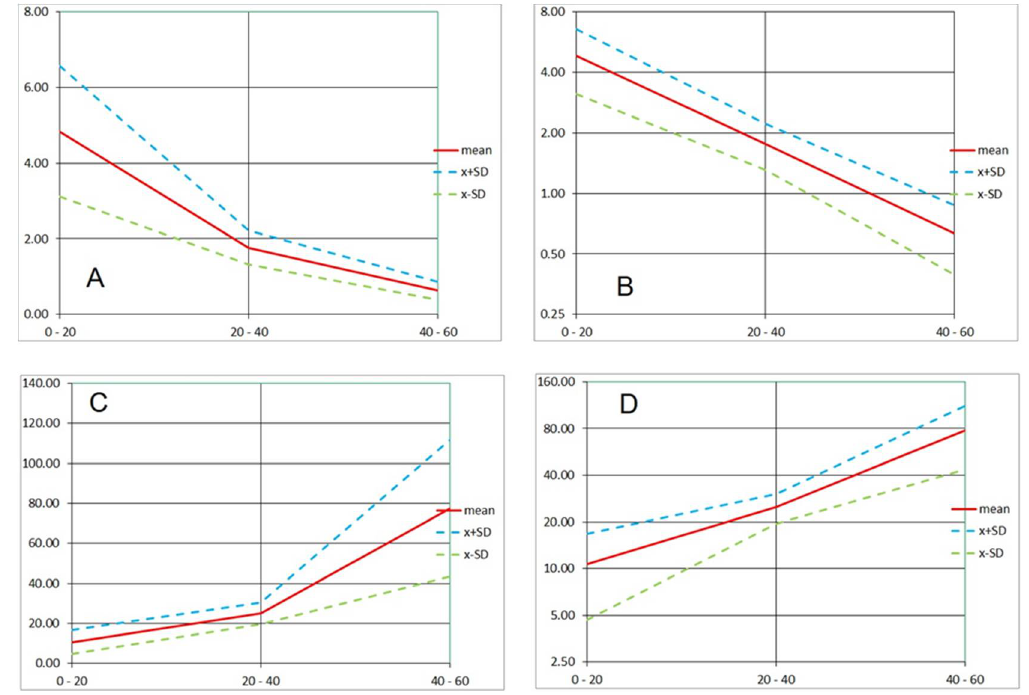
Figure 12. Timing of the Product “A” action. A and B: Rates of red (PI) signal change. C and D: Doubling times of red signal emission (A and C: linear scale; B and D: logarithmic scale. Mean and Standard Deviation of four runs (Run 1–4). Horizontal scale: time intervals of 60-min runs (in minutes). Vertical scales: A and B: h −1 ; C and D: minutes.